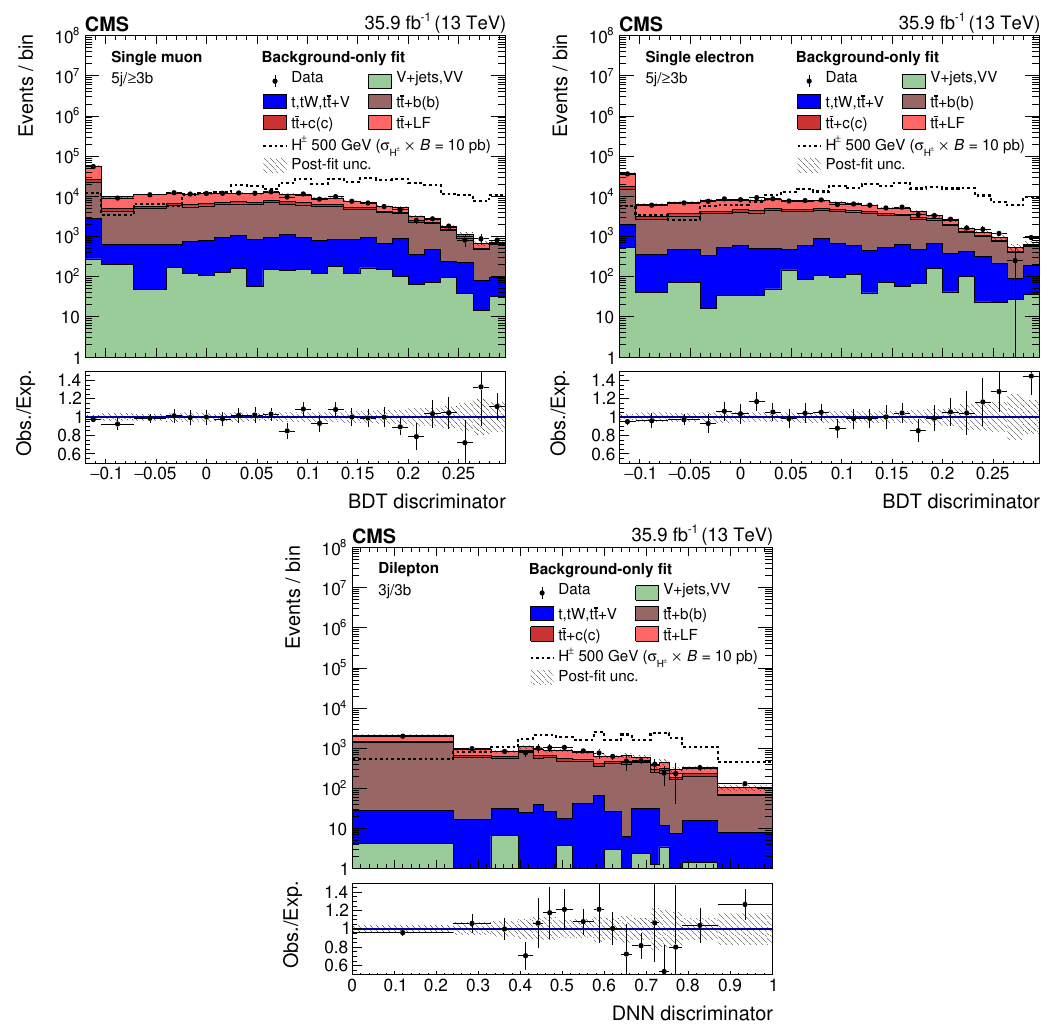
Figure 4 . Distributions of the MVA outputs of the data and the SM expectation after the background-only (cid:12)t to the data for the single-muon 5j/ 3b category (top left), for the single- (cid:21) electron 5j/ 3b category (top right), and for the dilepton 3j/3b category (bottom). The black (cid:21) markers show the data. The solid histograms represent the background prediction for tt+LF (light red), tt+c(c) (dark red), tt+b(b) (brown), single top quark and tt in association with extra bosons (blue), and V+jets and multiboson production (light green). The dashed line represents the yields for a charged Higgs boson with a mass of 500 GeV and a product of the cross section and branch- ing fraction of 10 pb. The lower panel shows the ratio of data to the SM expectation after the background-only (cid:12)t to the data and the hatched uncertainty bands include the total uncertainty. hypotheses between 200 and 3000 GeV. The observed (expected) upper limits with single- lepton and dilepton (cid:12)nal states combined are shown in (cid:12)gure 5 (left) and listed in table 3. The single-lepton and dilepton regions have comparable sensitivity in the low-mass regime ( 200 GeV) while the single-lepton regions become increasingly dominant at higher values (cid:25) of the mass hypothesis; (cid:12)gure 5 (right) details the contributions of the single-lepton and dilepton regions. Using the MVA classi(cid:12)er instead of the H -based approach of the pre- T